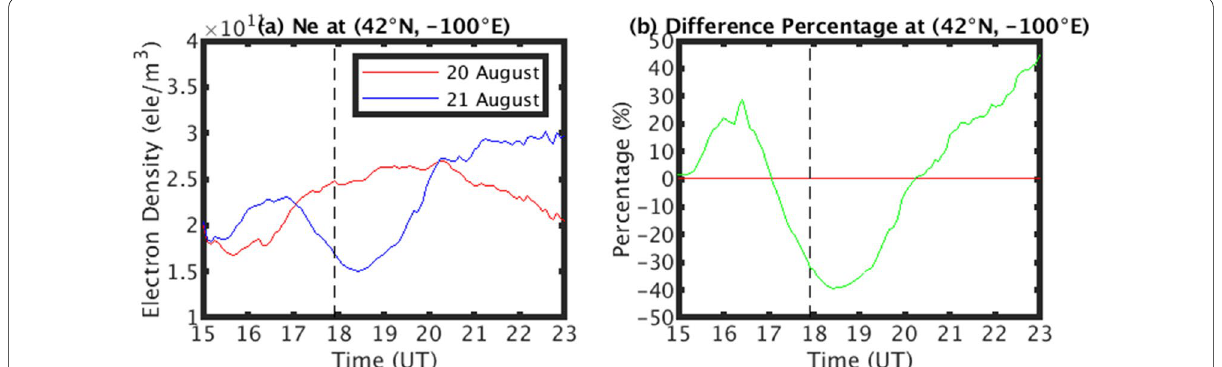
Fig. 5 The comparison of electron densities between the eclipse day and the reference day ( a) as well as their difference percentage ( b) at 260 km altitude at the fixed location of (42 o N, 100 o E). The vertical dash-line indicates the time of maximum −